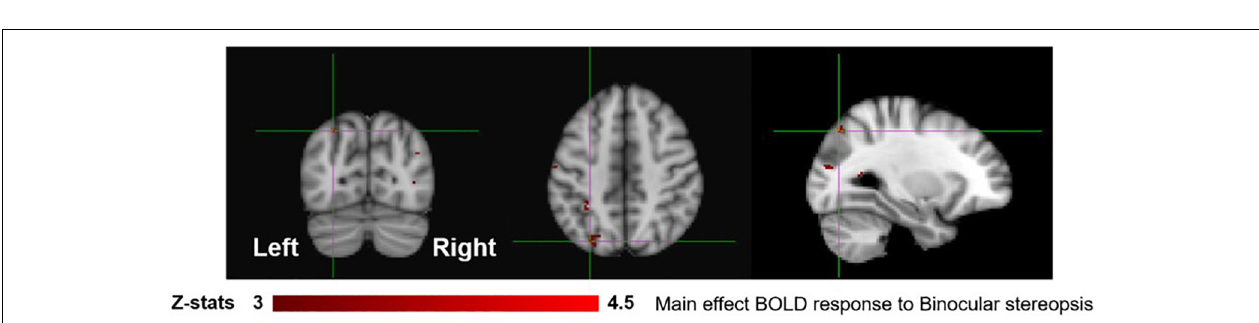
FIGURE 5 | Group results for monocular stereopsis, revealed by the fixed-effects ( N = 7) GLM contrast [MaP INTACT > MaP SCRAMB ] > [BP INTACT > BP SCRAMB ]. All responses are masked to gray matter. Uncorrected p < 0.001. The crosshairs represent the peak in the left parietal cortex [MNI coordinates: − 28, − 60, and 54].